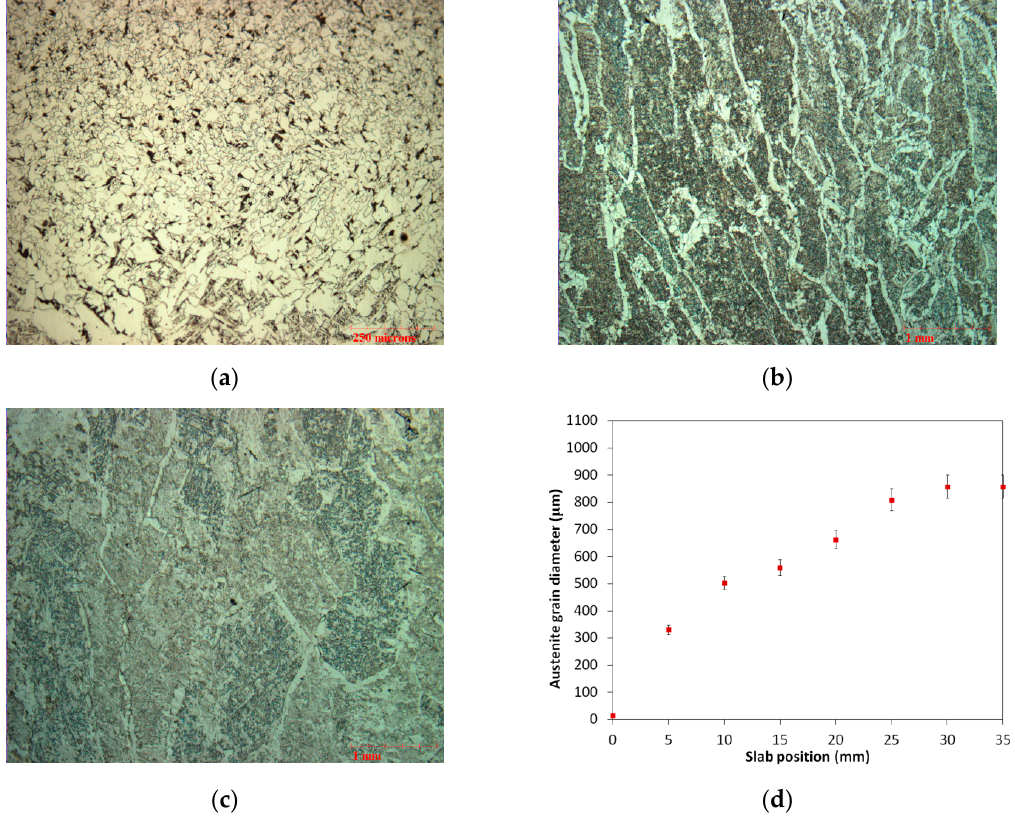
Figure 3. 70-mm slab austenite grain size evolution of API X70 from the industrial thin slab casting process: ( a ) close to slab surface; ( b ) 20 mm from the slab surface; ( c ) close to the slab center; and ( d ) summary of the measured austenite grain size with distance from slab surface to center. Table 2. Phase transformation temperature of API X